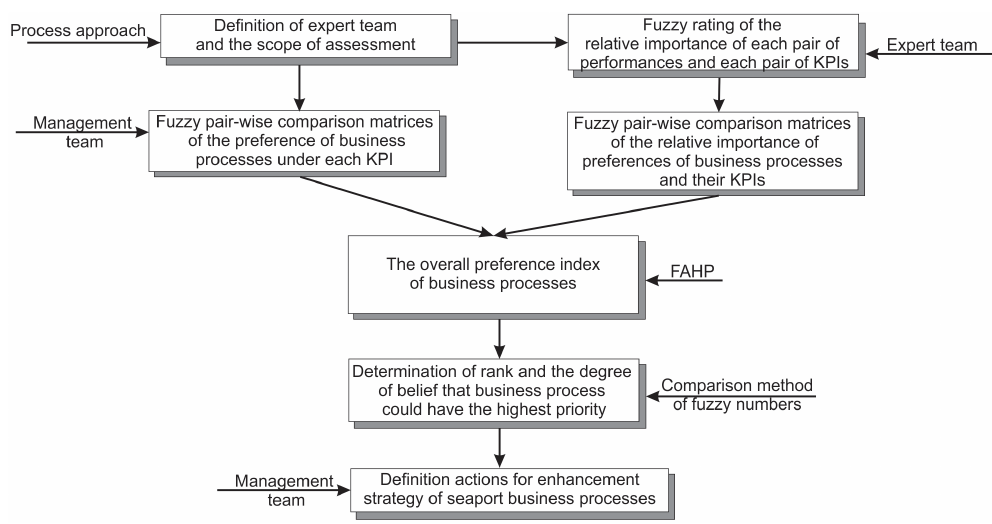
Figure 1. The evaluation procedure of seaport business processes by